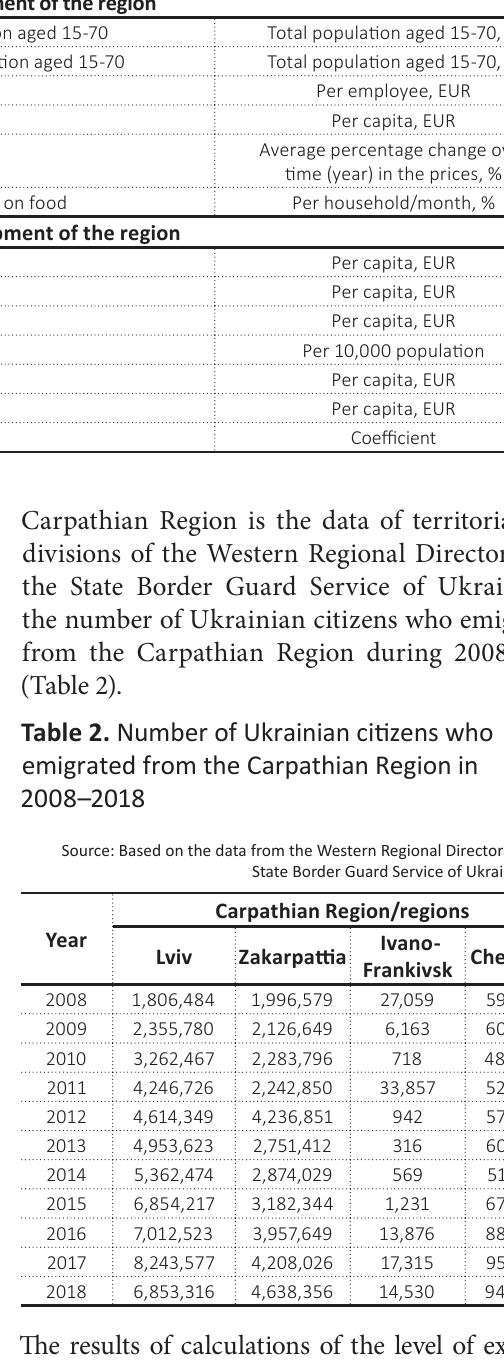
Table 1. Indicators of socio-economic development of the Carpathian Region